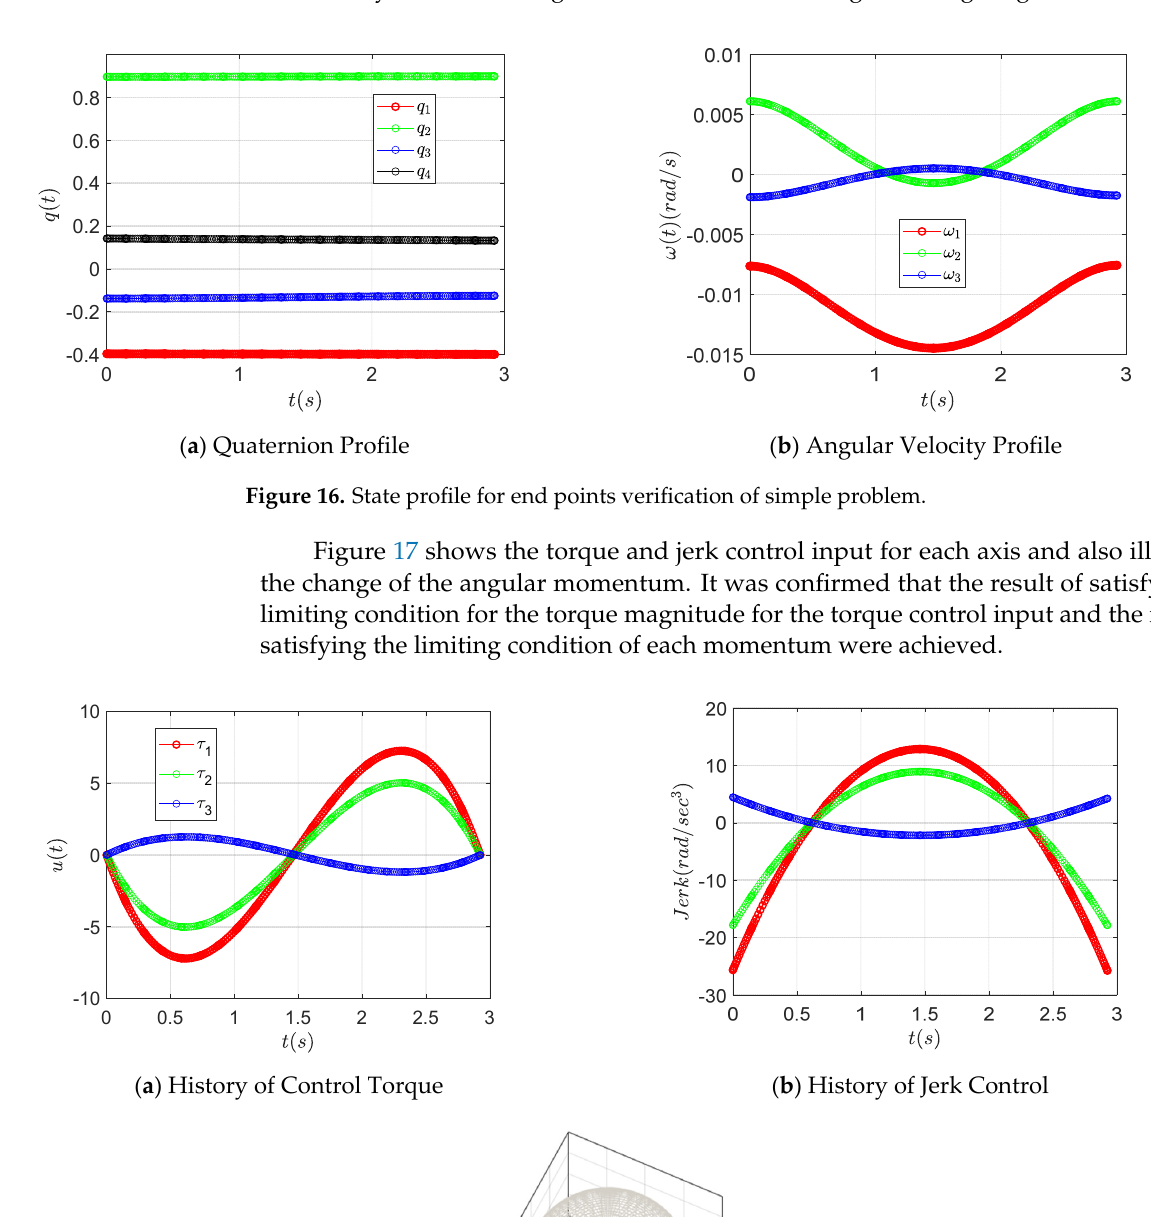
Figure 15. Conceptual scheme of a hp-PattersonRao on GPOPS-II. As an initial value for verification, quaternion is [ − 0.396, 0.896, − 0.138, 0.142] and angular velocity is [ − 0.436, 0.350, − 0.108] rad/sec. In this verification simulation, MoI is assumed to be [1000, 700, 500] kgm 2 for the general demonstrative case. It can be confirmed to normally track according to constraints for final targets through Figure 16.